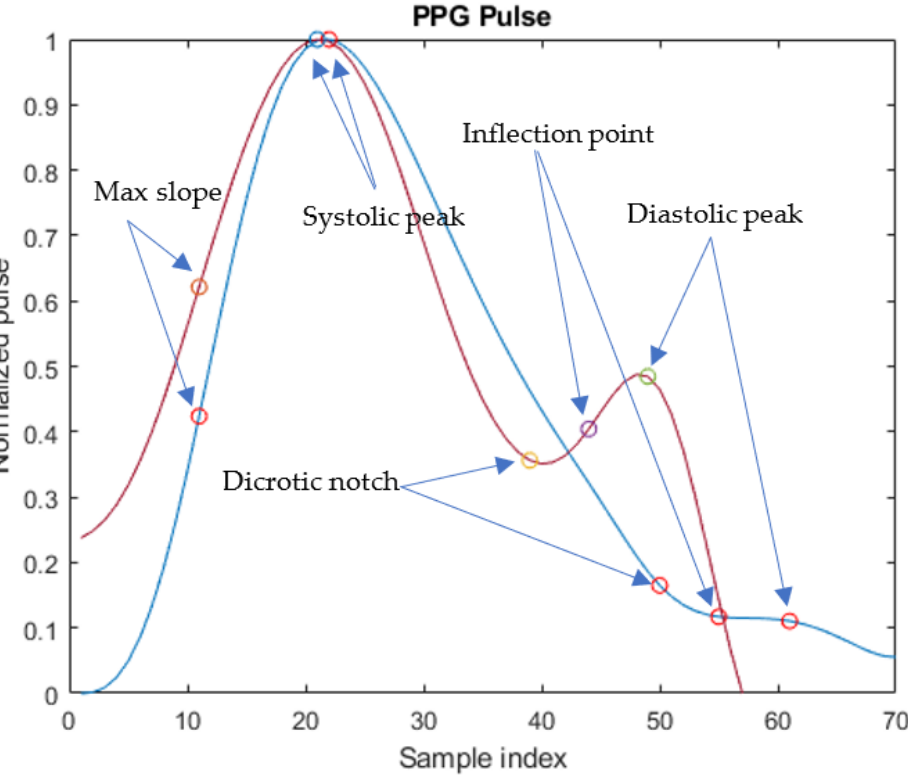
Figure 3. Different morphologies of PPG pulses of x NORM with characteristic points for two different patients: (blue pulse) adult patient; (red pulse) neonate patient. Sampling frequency is 125 Hz.